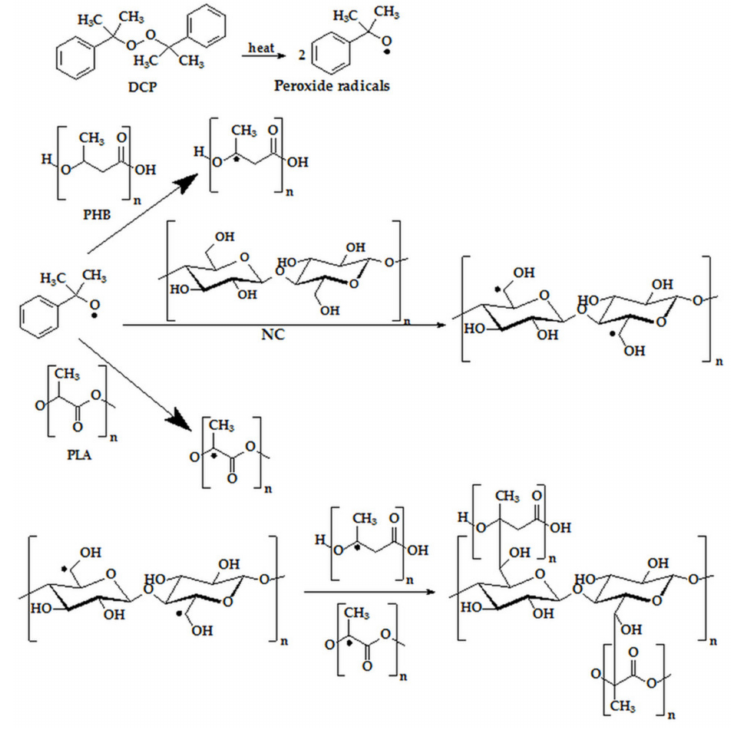
Figure 6. Mechanism of grafting PLA / PHB onto